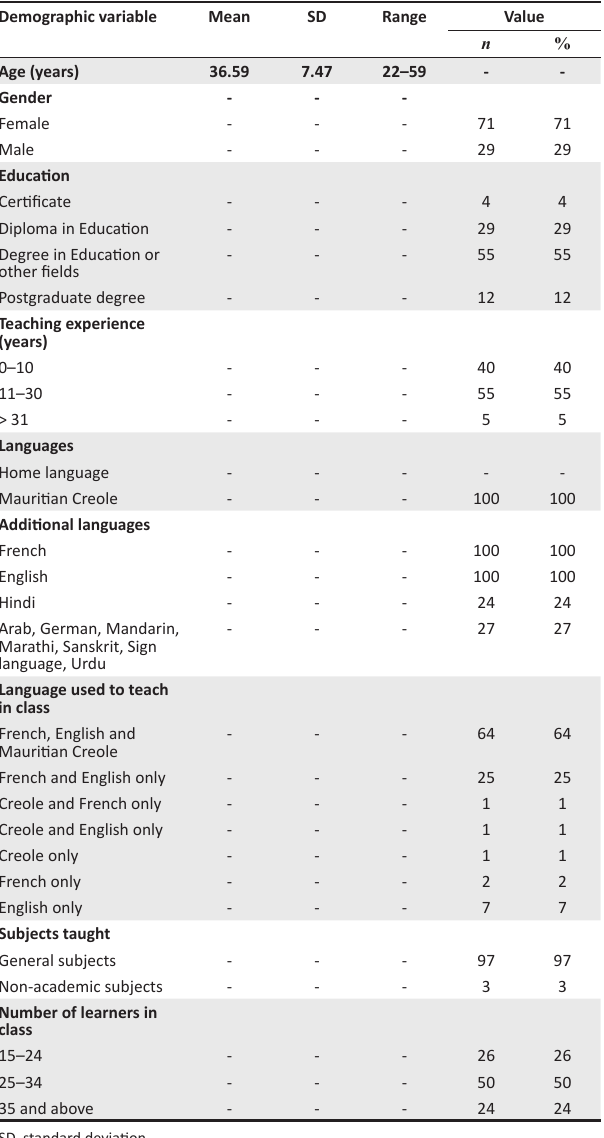
TABLE 1: Teacher characteristics ( n = 100). Demographic